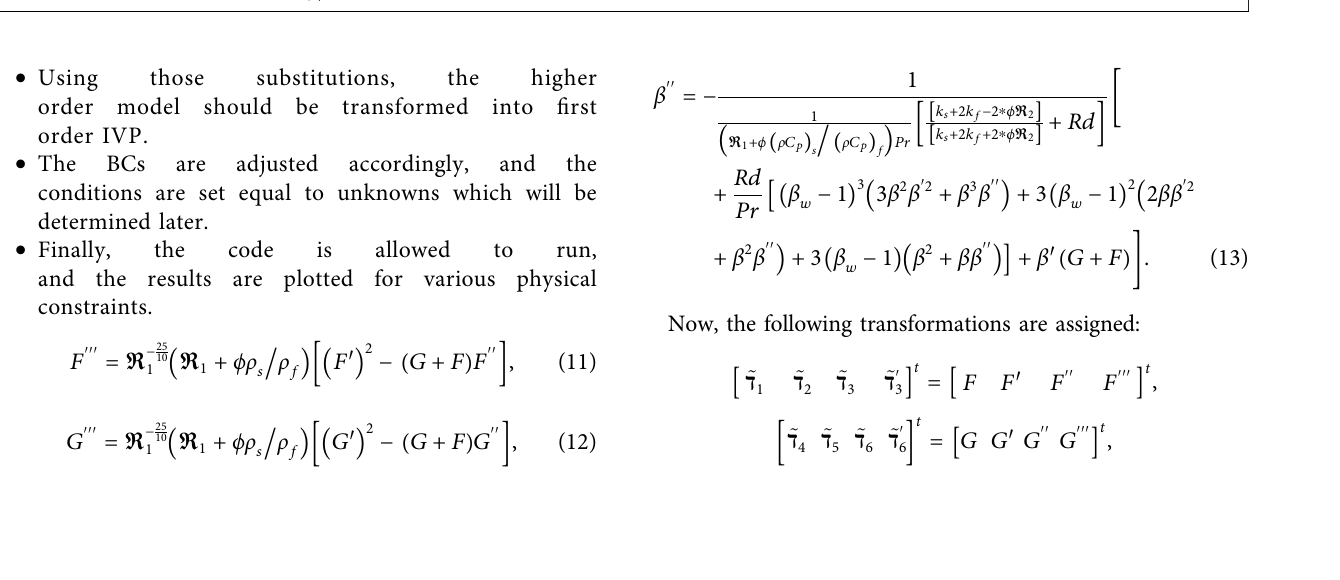
FIGURE 14 | Skin friction via (A) R 1 (B) γ 1 and (C) S t .